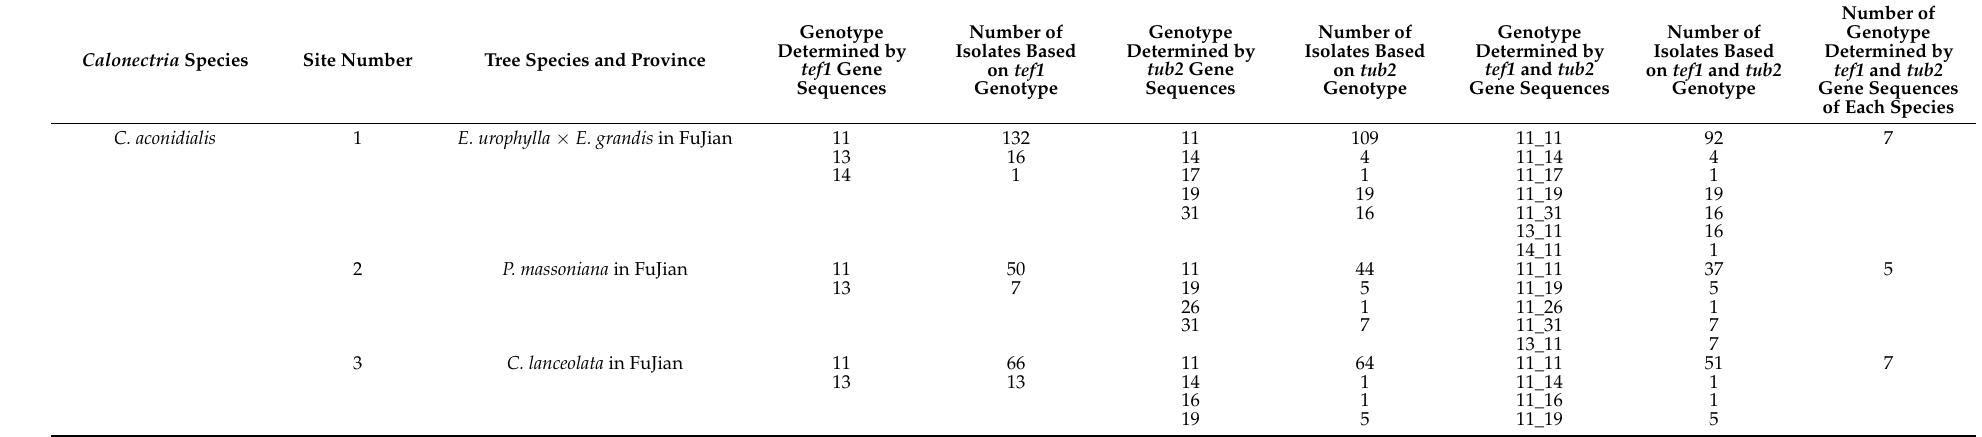
Table A2. Isolate numbers of each genotype in the plantation of each tree species in each province for each Calonectria